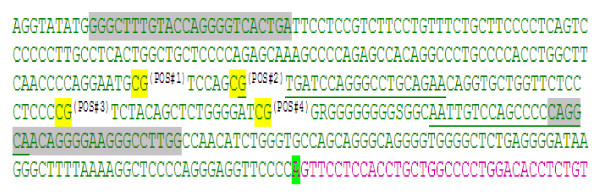
Map of CpG sites studied in the human KLK1 proximal promoter. Letters highlighted in gray are the target regions complementary to amplified PCR primers. The CpGs analyzed are numbered as Pos#1 - Pos#4 and colored yellow. Green underlined sequences are target regions complementary to sequencing primers. Green highlighted A is the transcriptional initiation ("cap") site. Sequences following the transcription initiation site are colored pink.